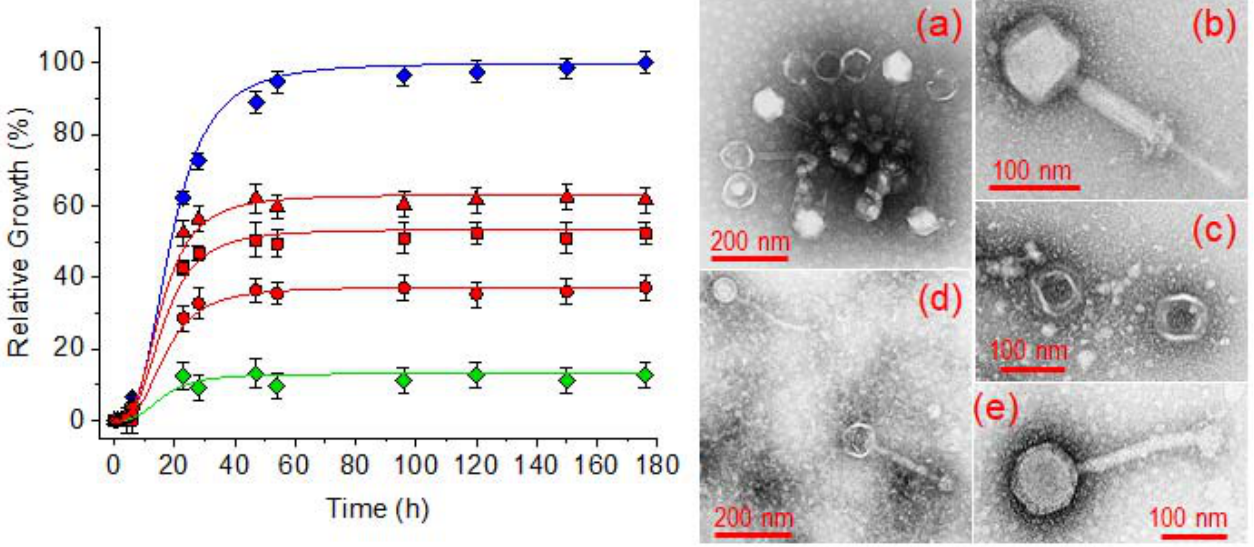
Figure 12. Antibacterial activity of the Fersisi bacteriophages. Control of the Staphylococcus aureus bacterial growth (blue), relative growth of S. aureus in the commercial preparation of phages (green) and bacteriophage-loaded electrospun hydrogels (red) with crosslinking degrees of 100% (circles), 75% (squares) and 50% (triangles). TEM micrographs show the morphology of Fersisi bacteriophages (commercial preparation): ( a ) Myoviridae , ( b ) Siphoviridae , ( c ) Leviviridae , and ( d , e ) Podoviridae .